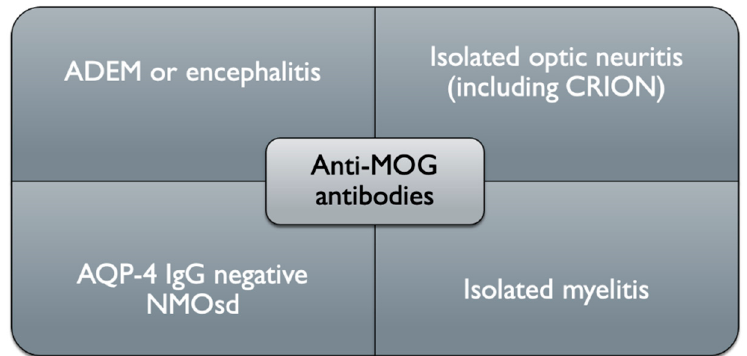
Figure 3. Schematic clinical representation of anti-MOG associated disorders (ADEM, acute disseminated encephalomyelitis, AQP-4, aquaporin-4, MOG, myelin oligodendrocyte glycoprotein, CRION, chronic relapsing inflammatory optic neuropathy, NMO, neuromyelitis optica ).